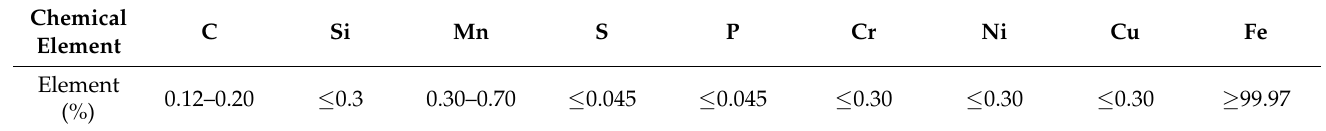
Table 1. Composition of Q235 carbon steel material.